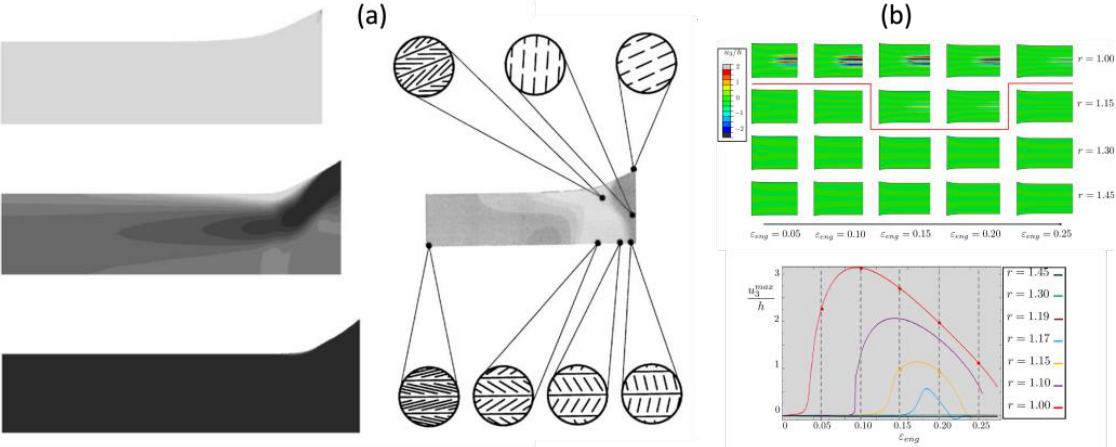
Figure 9. Tension-induced instability of the nematic solid: ( a ) uniaxial tension-induced evolution of the von Mises stress ( left ) and texture ( right ), where darker colors denote higher stress concentration and higher index number (Adapted with permission from Ref. [84]. 2002, Conti, S. et al.) ( b ) under various order parameters (r); changes in the scaled out-of-plane displacement ( 𝑢 3𝑚𝑎𝑥 /ℎ ) occur with increased stretch ( 𝜖 𝑒𝑛𝑔 ) . The higher the order parameters, the fewer micro-wrinkles observed (Adapted with permission from Ref. [53]. 2017, Plucinsky, P. et al.).